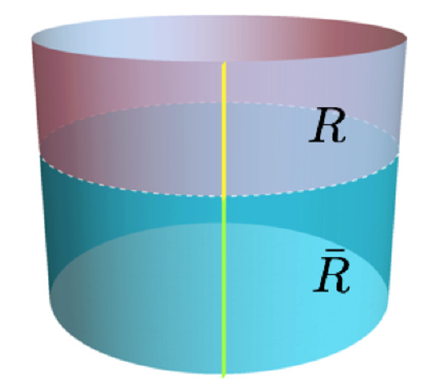
Figure 4. There is an interface between region R and (cid:22) R , which coincides with the entanglement cut (white dashed line). Di(cid:11)erent anyons are matched across the